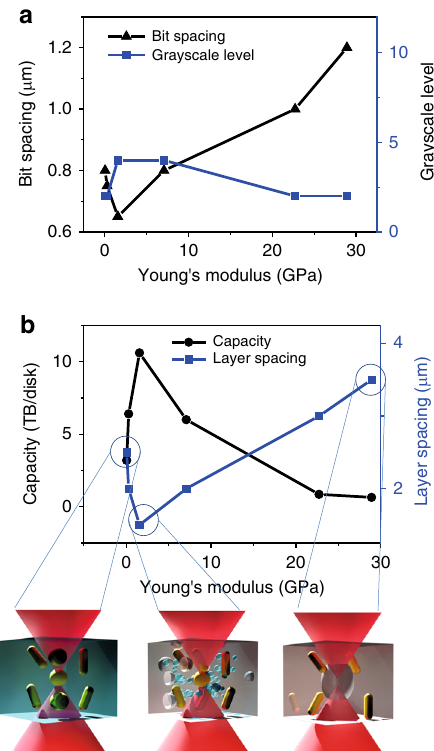
Fig. 3 High-capacity optical data memory in nanoplasmonic hybrid glass composites. a Bit spacing and gray-scale level of optical data memory of nanoplasmonic hybrid glass composites with different Young ’ s moduli. b Capacity and layer spacing of the optical data memory in nanoplasmonic hybrid glass composites. Inset: Schmatic drawing of laser melting of gold nanoparticles in low Young ’ s modulus (Left), laser melting of gold nanoparticles with smaller spot size in enhanced Young ’ s modulus (Middle), and laser induced micro-explosion in high Young ’ s modulus